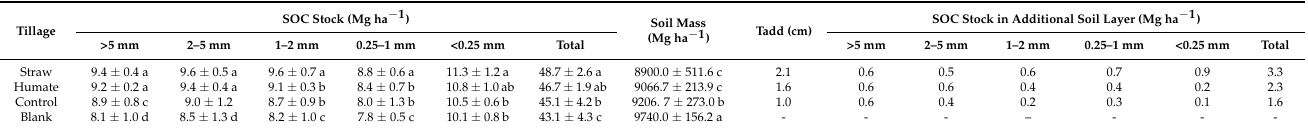
Table 4. SOC stock in the 0–60-cm soil profile estimated by the equivalent soil mass (EMS) method at the end of the 3-year experiment in 2018.